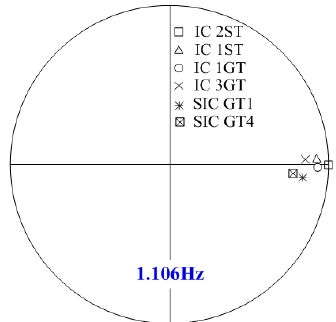
Figure 11. Sync of the local mode. IC 1ST: IC steam turbine unit 1; IC 2ST: IC steam turbine unit 2; IC 1GT: IC gas turbine unit 1; IC 3GT: IC gas turbine unit 3; SIC GT1: SIC gas turbine unit 1; and SIC GT4: SIC gas turbine unit 4.